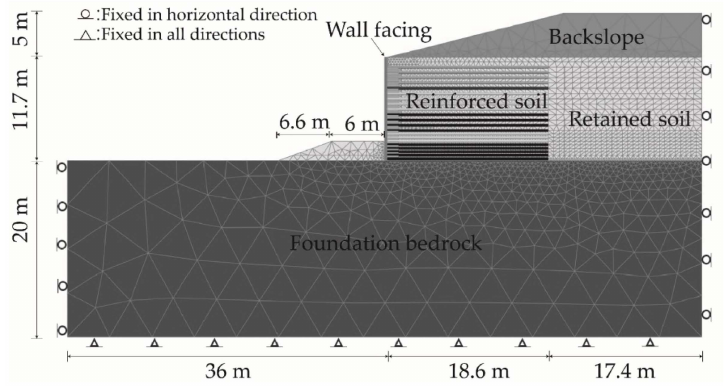
Figure 3. The mesh and boundary conditions of the field GRS wall with secondary reinforcement model.